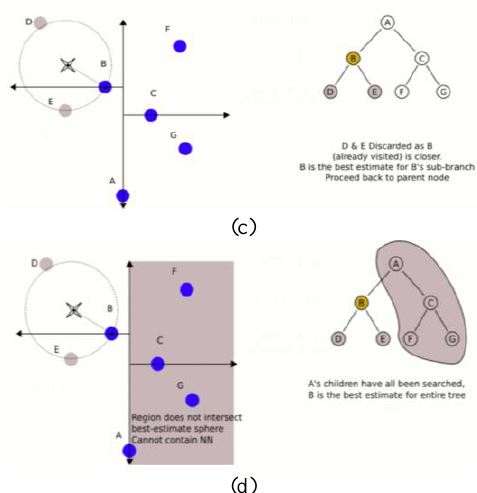
Figure 13 . Nearest Neighbour Search